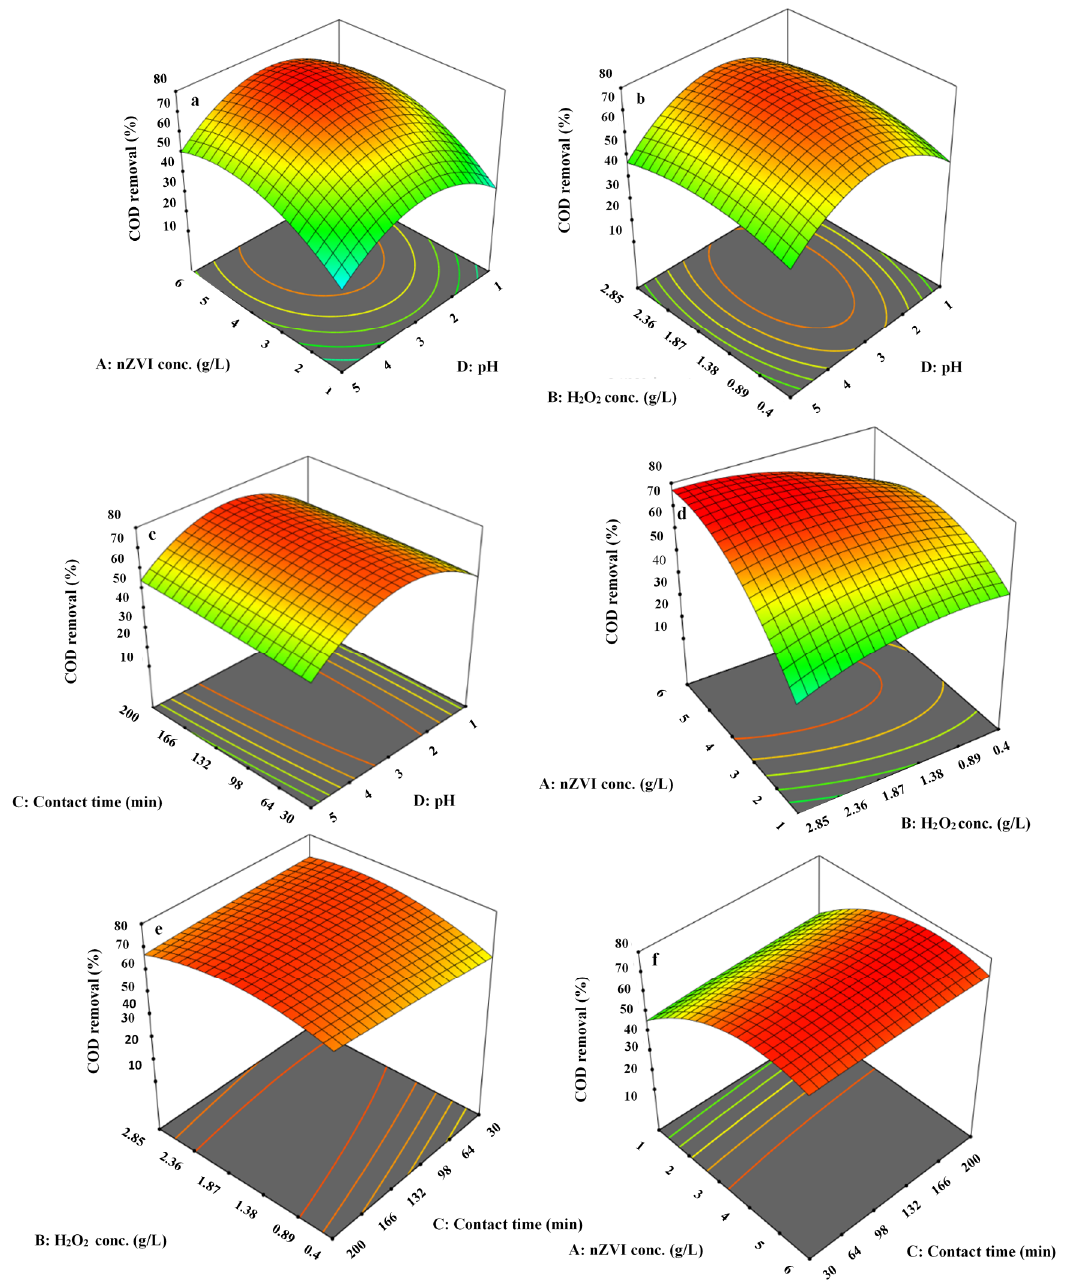
Figure 7. COD removal (%) 3D plot; ( a ) nZVI dosage vs. pH, ( b ) H 2 O 2 conc. vs. pH ( c ), contact time vs. pH, ( d ) nZVI dosage vs. H 2 O 2 ( e ), H 2 O 2 conc. vs. contact time, ( f ) nZVI vs. contact time.